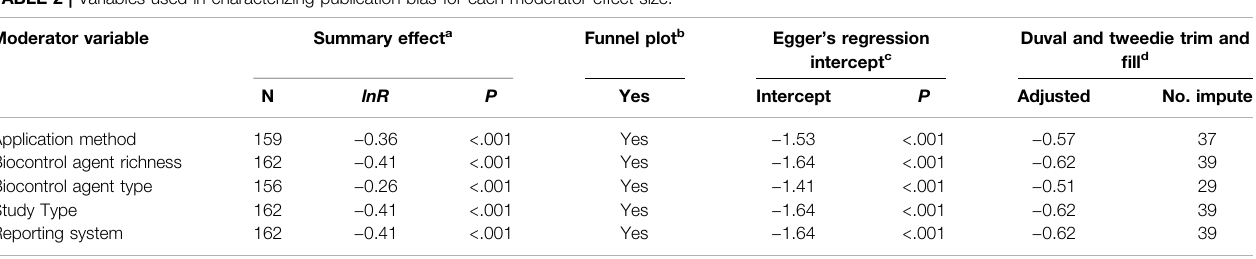
TABLE 2 | Variables used in characterizing publication bias for each moderator effect